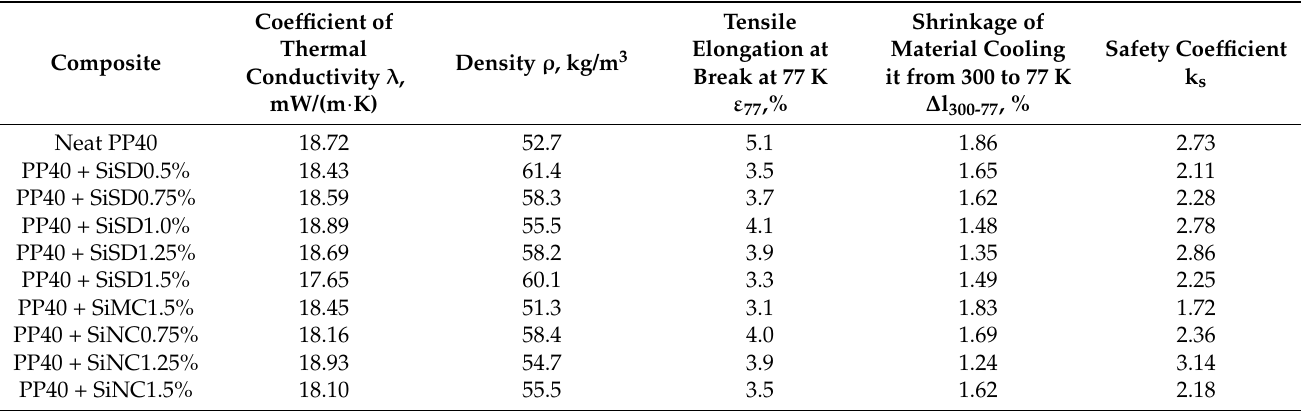
Table 3. Coefficient of thermal conductivity, density, tensile elongation at break at 77 K, shrinkage of material cooling it from 300 to 77 K, and safety coefficient of PP40 composites and neat